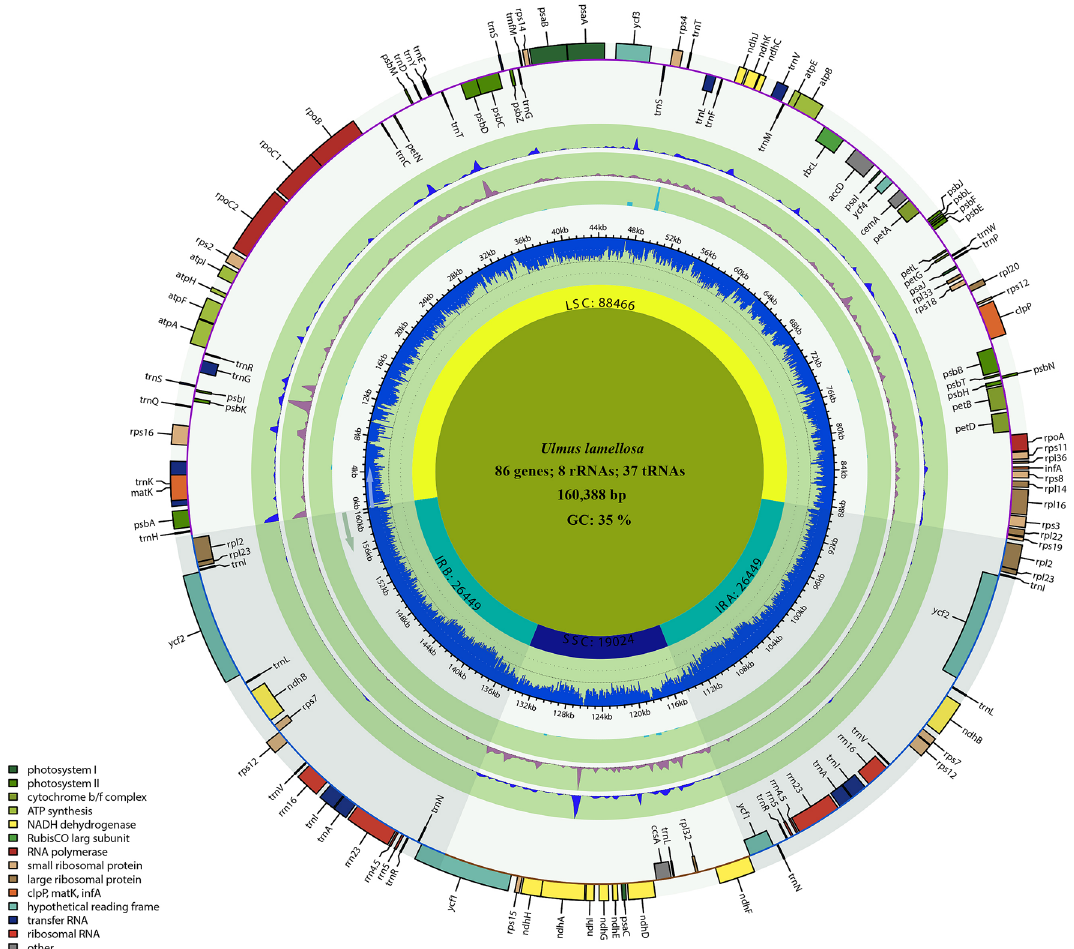
Figure 2. The cp genome maps of Ulmus species . The species name and specific information regarding the genome (length, GC content, and the number of genes) are depicted in the center of the plot. Extending outward, the four layers are the nucleotide diversity of U. pumila ‘zhonghuajinye’, U. parvifolia, U. castaneifolia and U. lamellosa